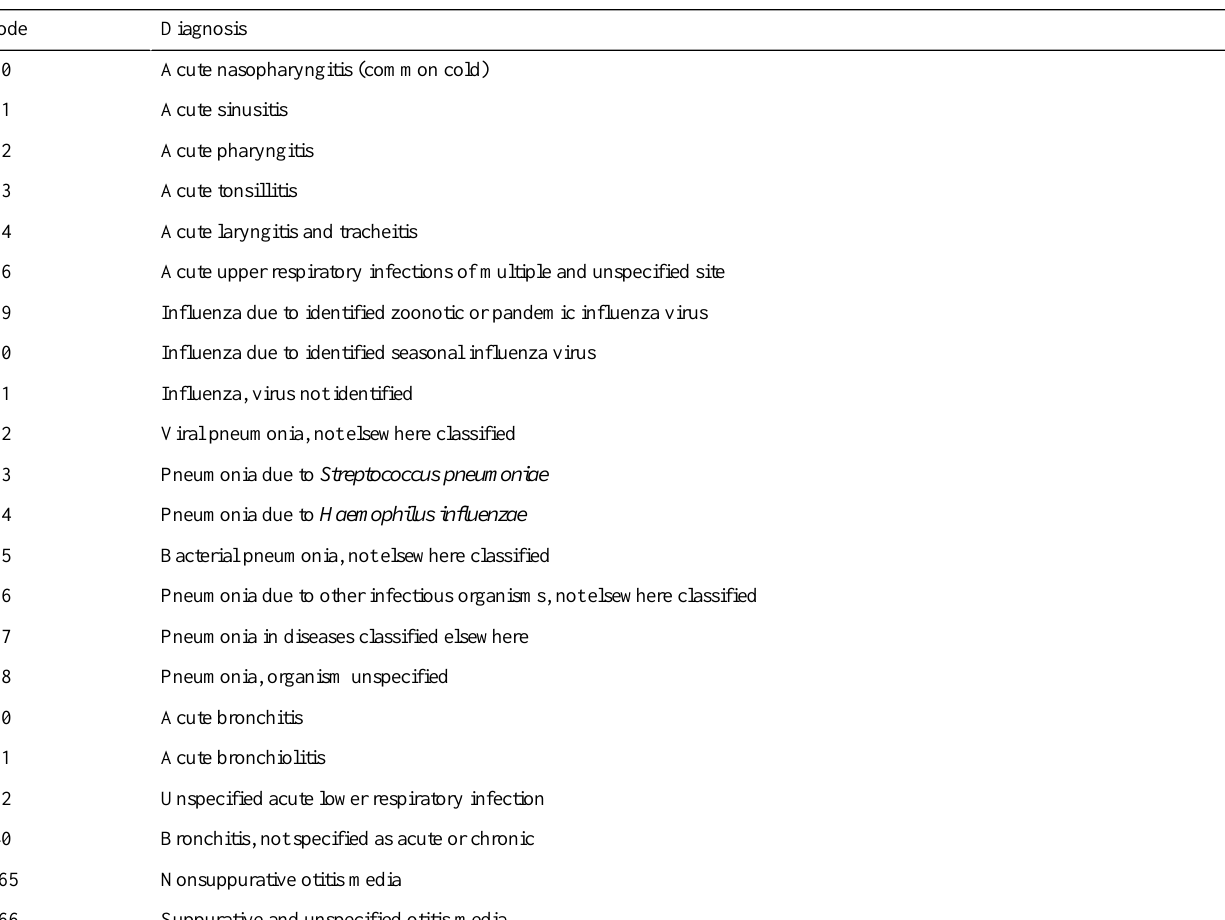
Table 1. International Classification of Diseases codes relevant for diagnosing acute respiratory tract